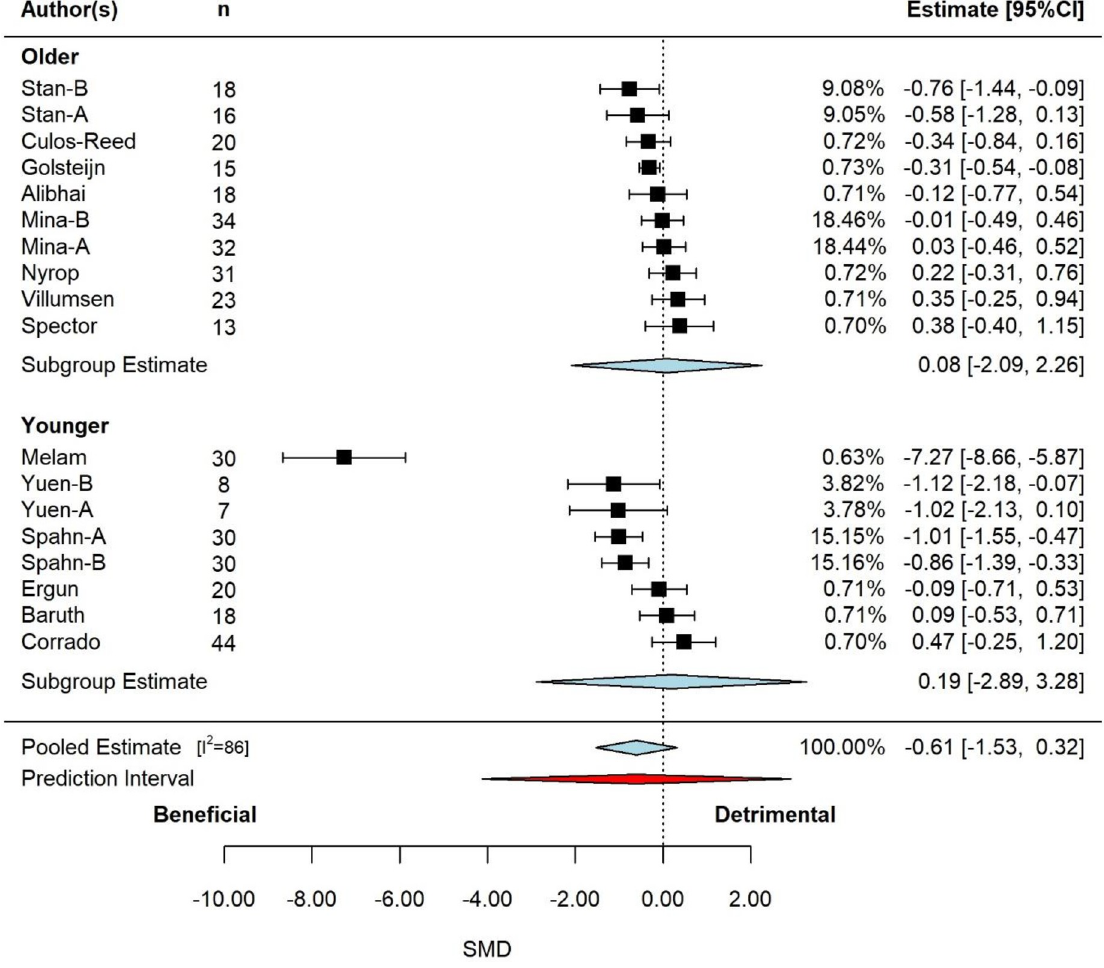
Fig 6. Pooled effect of exercise intervention on fatigue, with sub-group analysis by age (k = 7, u = 12, n = 285). Based on the 3-level model, there was a moderate but non-significant effect (SMD = -0.61, 95% CI: -1.53 to 0.32, p = 0.198). Abbreviations : CI, confidence interval; SMD, standardized mean